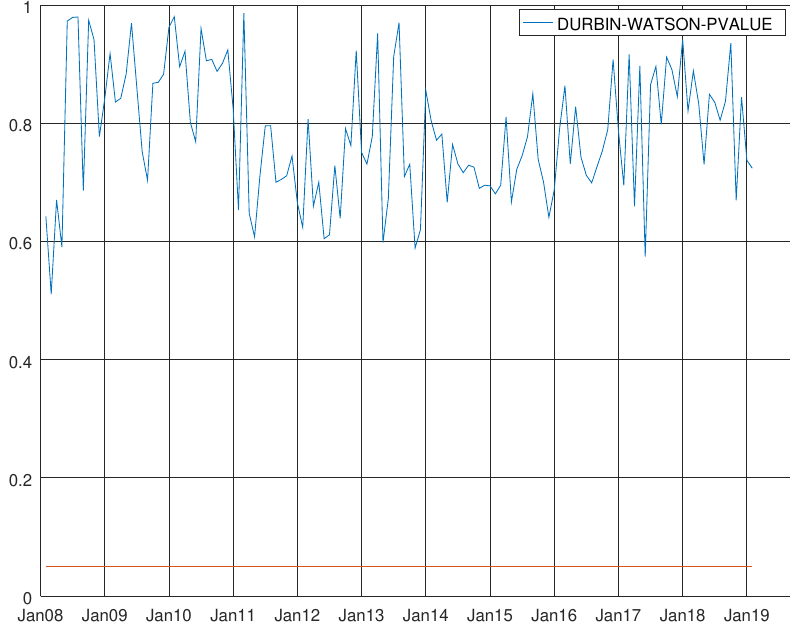
Figure 18. Graph showing the p -values of the Bowman–Shenton test for the enhanced model for capital goods. The null hypothesis states that errors are normally distributed.